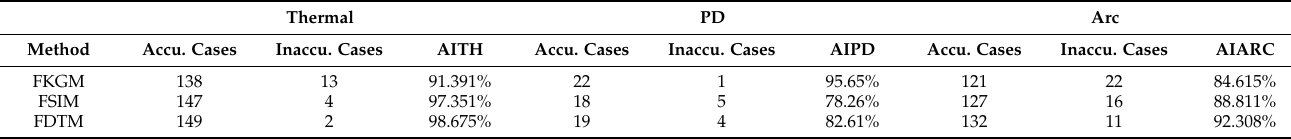
Table 4. Accuracy index values.